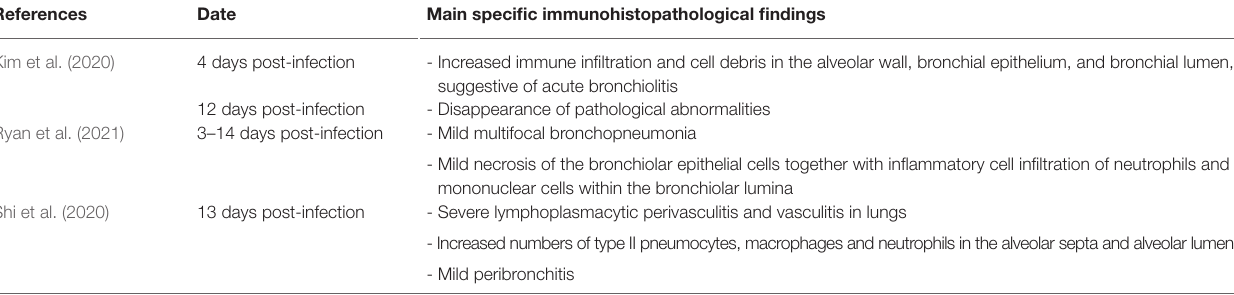
TABLE 1 | Histopathological abnormalities observed in an experimental ferret model.